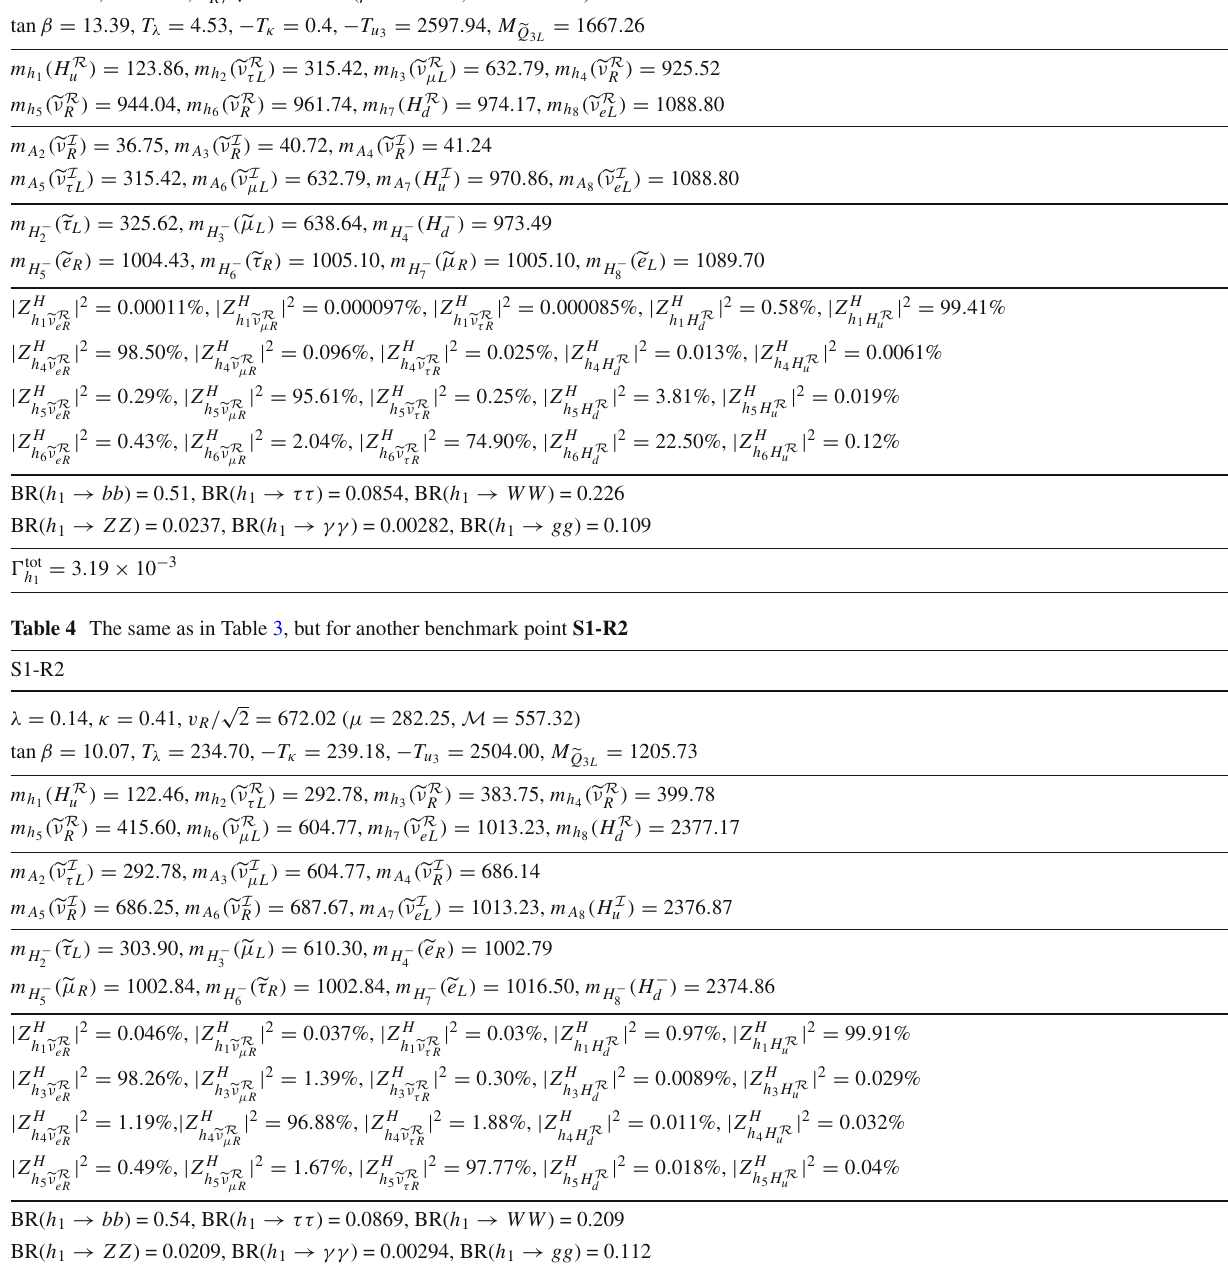
Table 3 Benchmark point S1-R1 from scan S 1 , with the SM-like associating the first doscalars by A 2 ,..., 8 and charged Higgses by H − 2 ,..., 8 Higgs h 1 being the lightest scalar. Input parameters at the low scale states to the Goldstone bosons eaten by the Z and W ± . Their dominant M EWSB are given in the first box, where we also show for complete- √ √ composition is written in brackets. For the case of the SM-like Higgs ness μ = 3 λv R / 2 and M = 2 κv R / 2 since their values deter- and singlet-like scalars their main compositions are broken down in the mine Higgsino and right-handed neutrino masses. Scalar, pseudoscalar fifth box. Relevant branching ratios for the SM-like Higgs h 1 are shown and charged Higgs masses are shown in the second, third and fourth in the sixth box. Its decay width is shown in the seventh box. VEVs, boxes,respectively.Scalarmasseigenstatesaredenotedby h 1 ,..., 8 ,pseu- soft parameters, sparticle masses and decay widths are given in GeV S1-R1